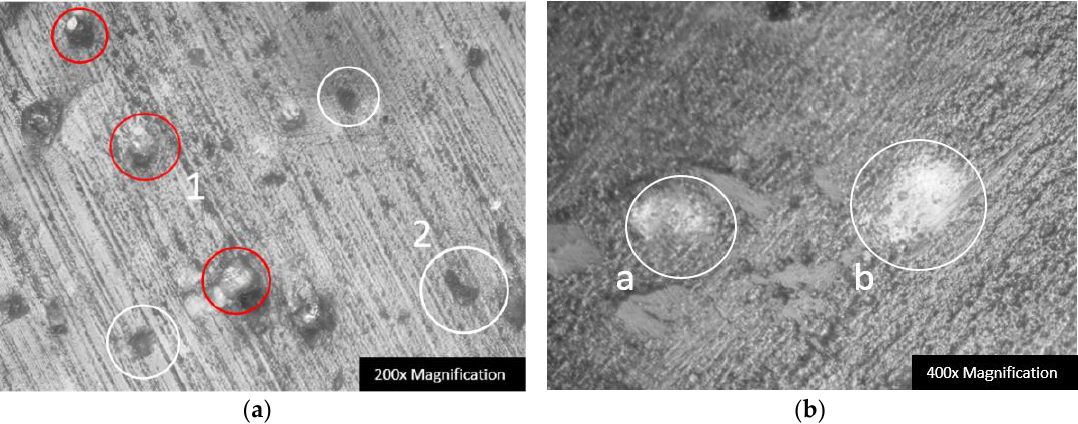
Figure 8. Worn surface of the ultraviolet-curable resin plate after lapping process: ( a ) the diamond grains working condition at 200× magnification with the active protruding diamond grains circled in red and pull-out holes circled in white, and ( b ) the diamond grains embedded within the resin matrix at various underneath heights circled and labelled as a and b .